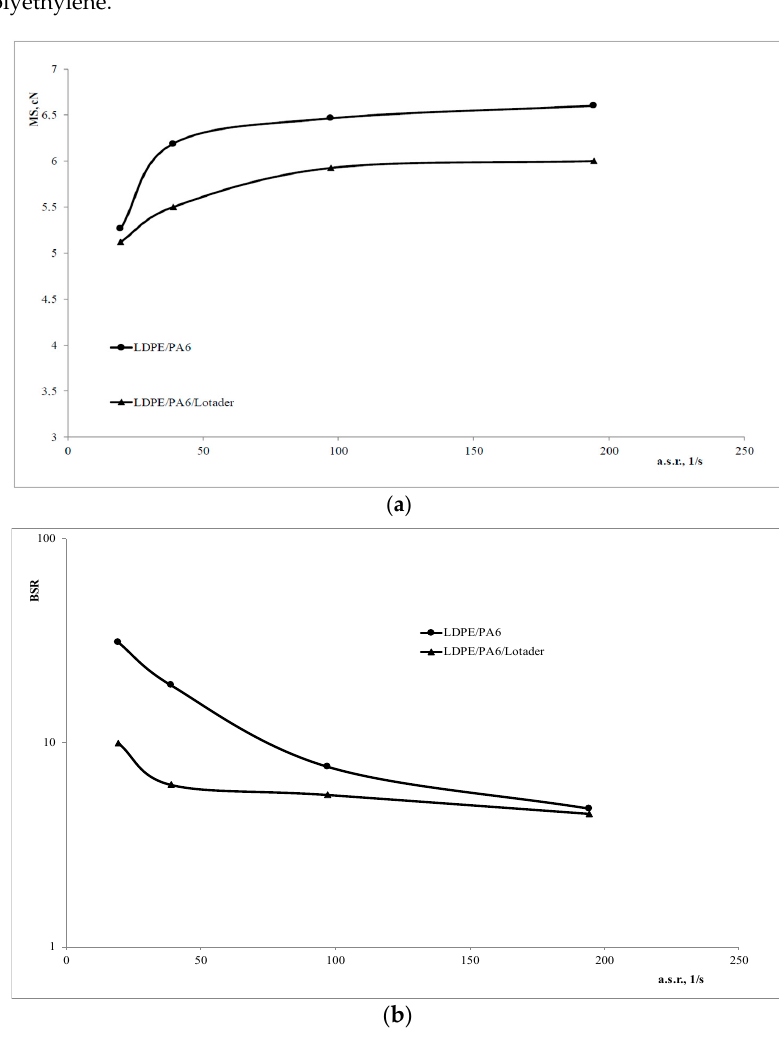
Figure 2. Melt strength, MS, ( a ) and breaking stretching ratio, BSR, ( b ) of the uncompatibilized and compatibilized blends.